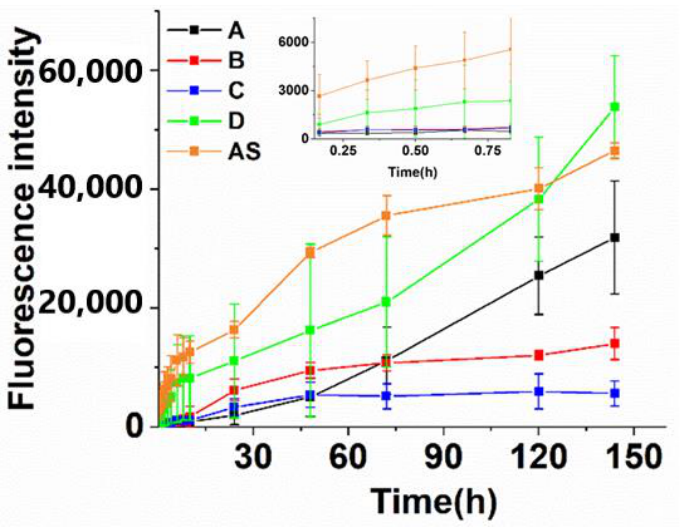
Figure 5 . Evaluation of drug (BSA as the representative compound) release profiles in different hydrogels in vitro . (The florescence intensity for 100% release is about 600,000.).